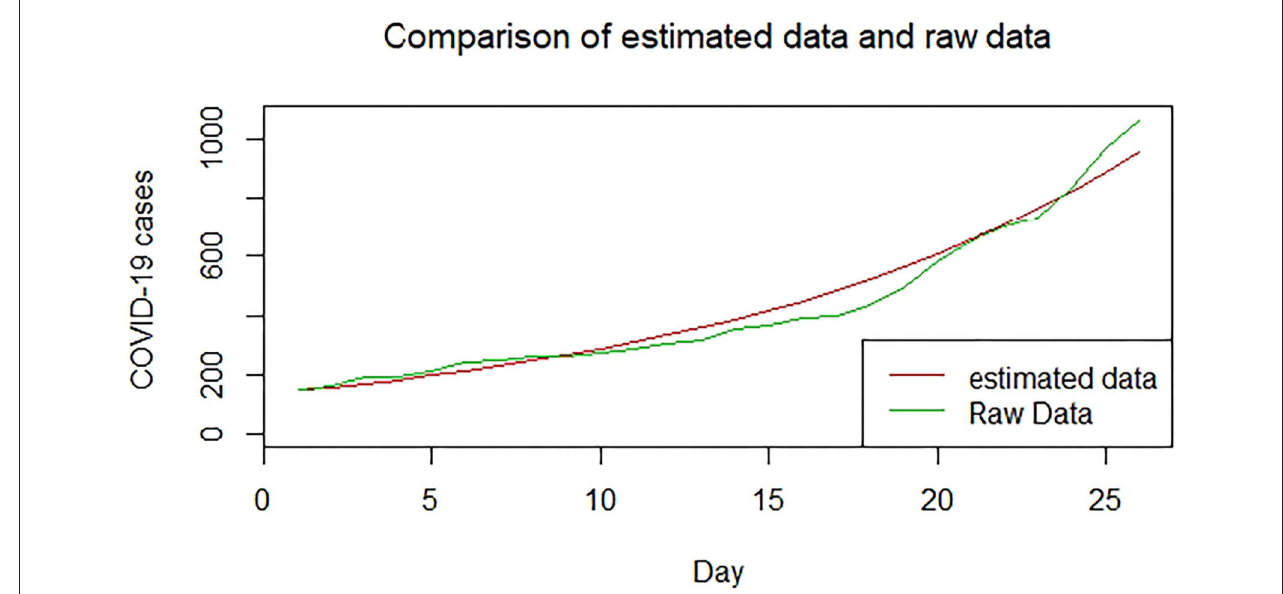
FIGURE 22 | Graph for Ethiopia.